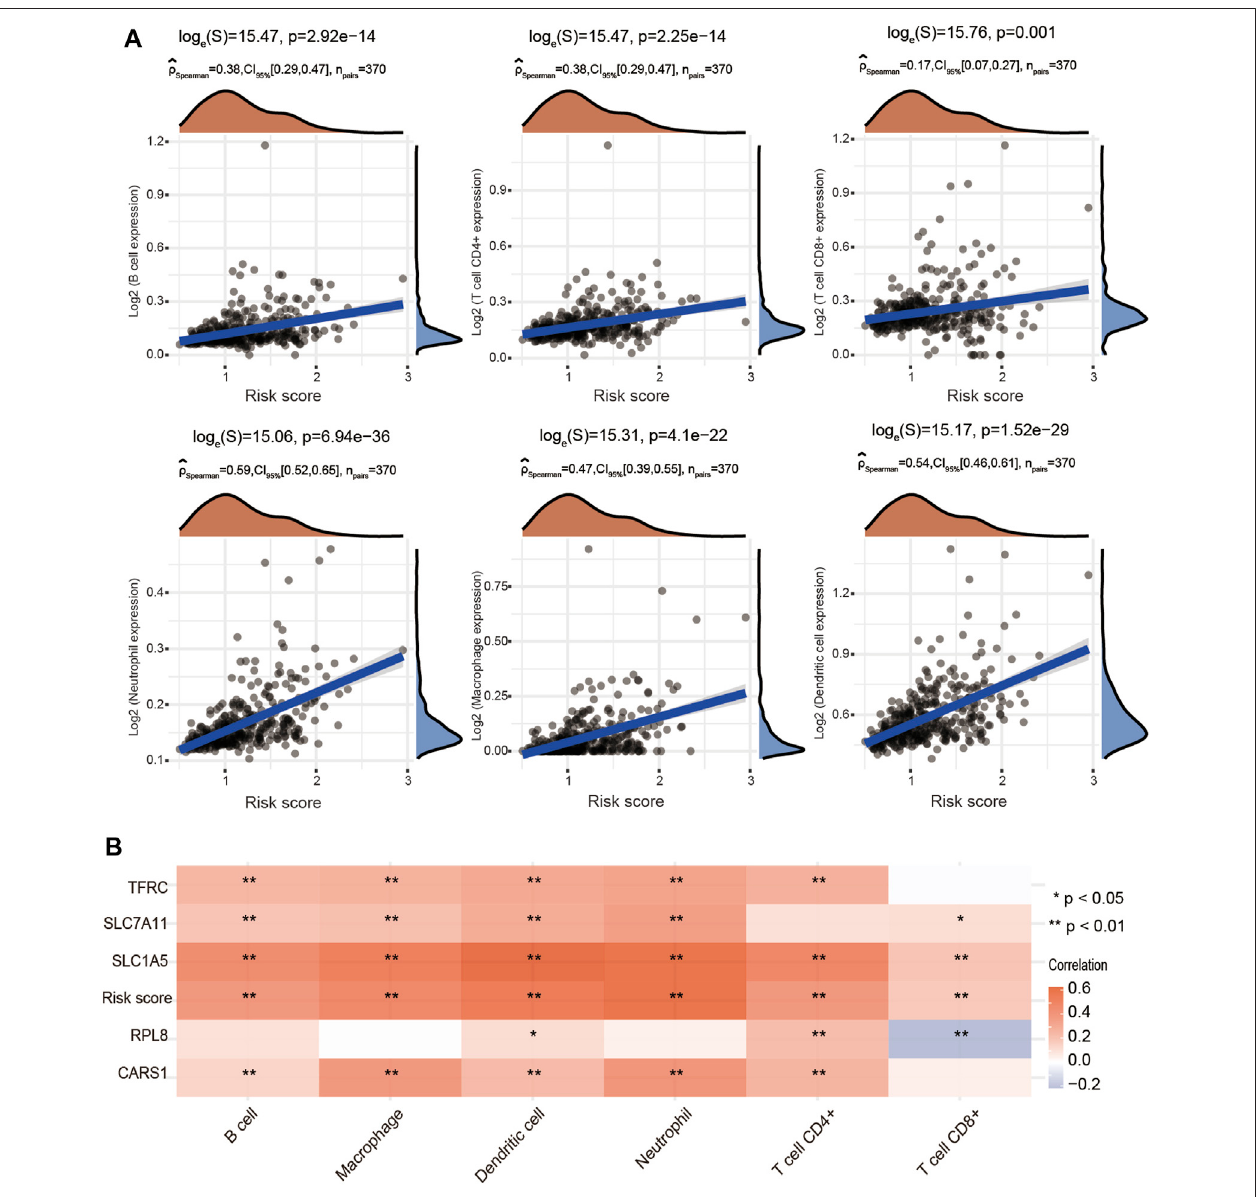
FIGURE 10 | Positive association of the risk score with immune cell in fi ltration in HCC. (A) Correlations between the risk score and the in fi ltration levels of B cells, CD4+Tcells,CD8+Tcells,macrophages,neutrophilsanddendriticcellsusingthespearmananalysis. (B) Heatmap showingthecorrelationbetweenriskscoreand fi ve ferroptosis-related genes and the in fi ltration levels of six major immune cells. Red represents a positive correlation and blue represents a negative correlation. * p < 0.05, ** p < 0.01.